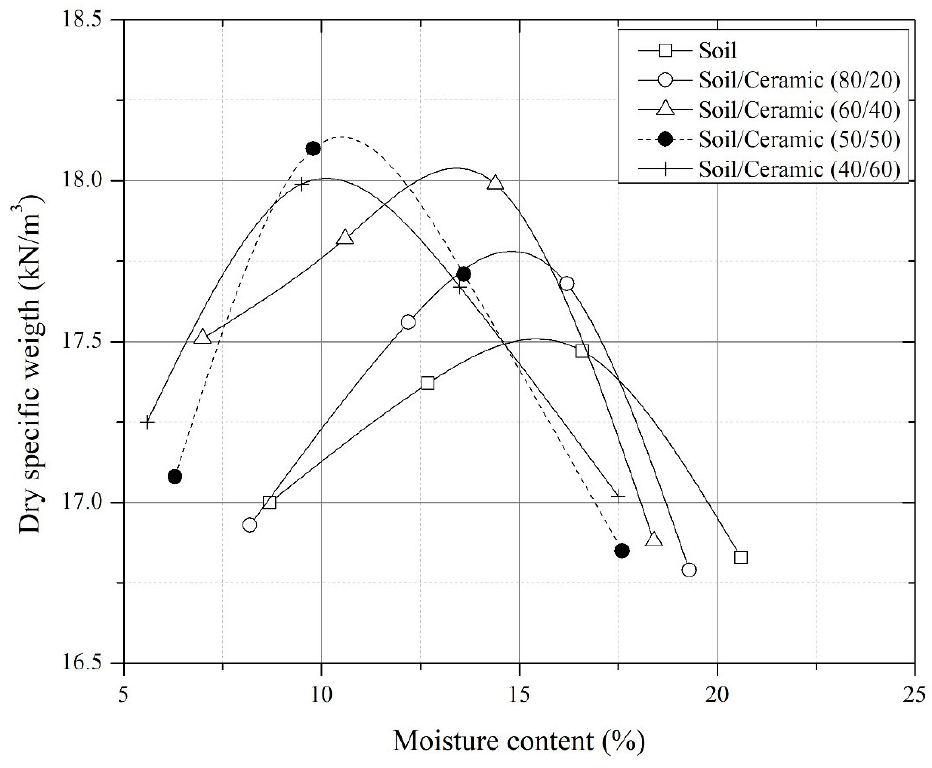
Figure 6. Modified Proctor tests of the soil mixture with CDW of ceramic veneer.